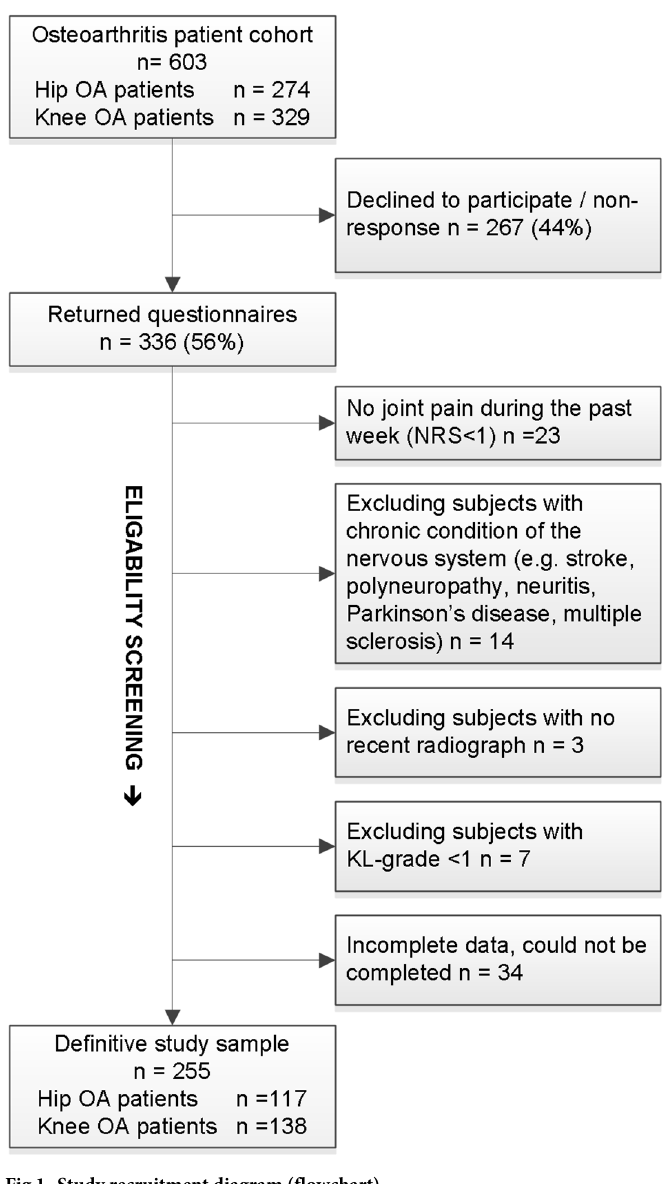
Fig 1. Study recruitment diagram